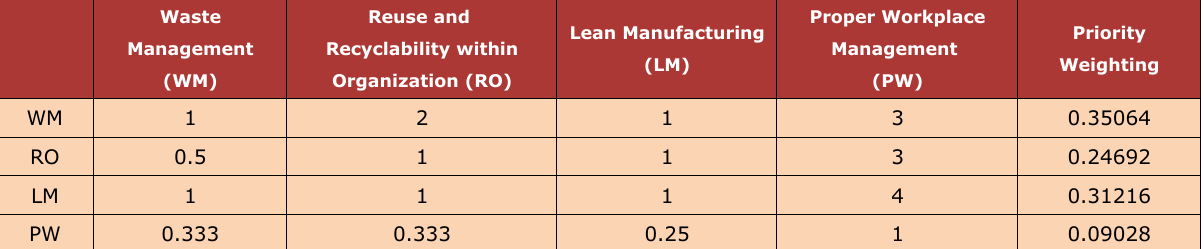
Table 5.3. Strategies of Industrial